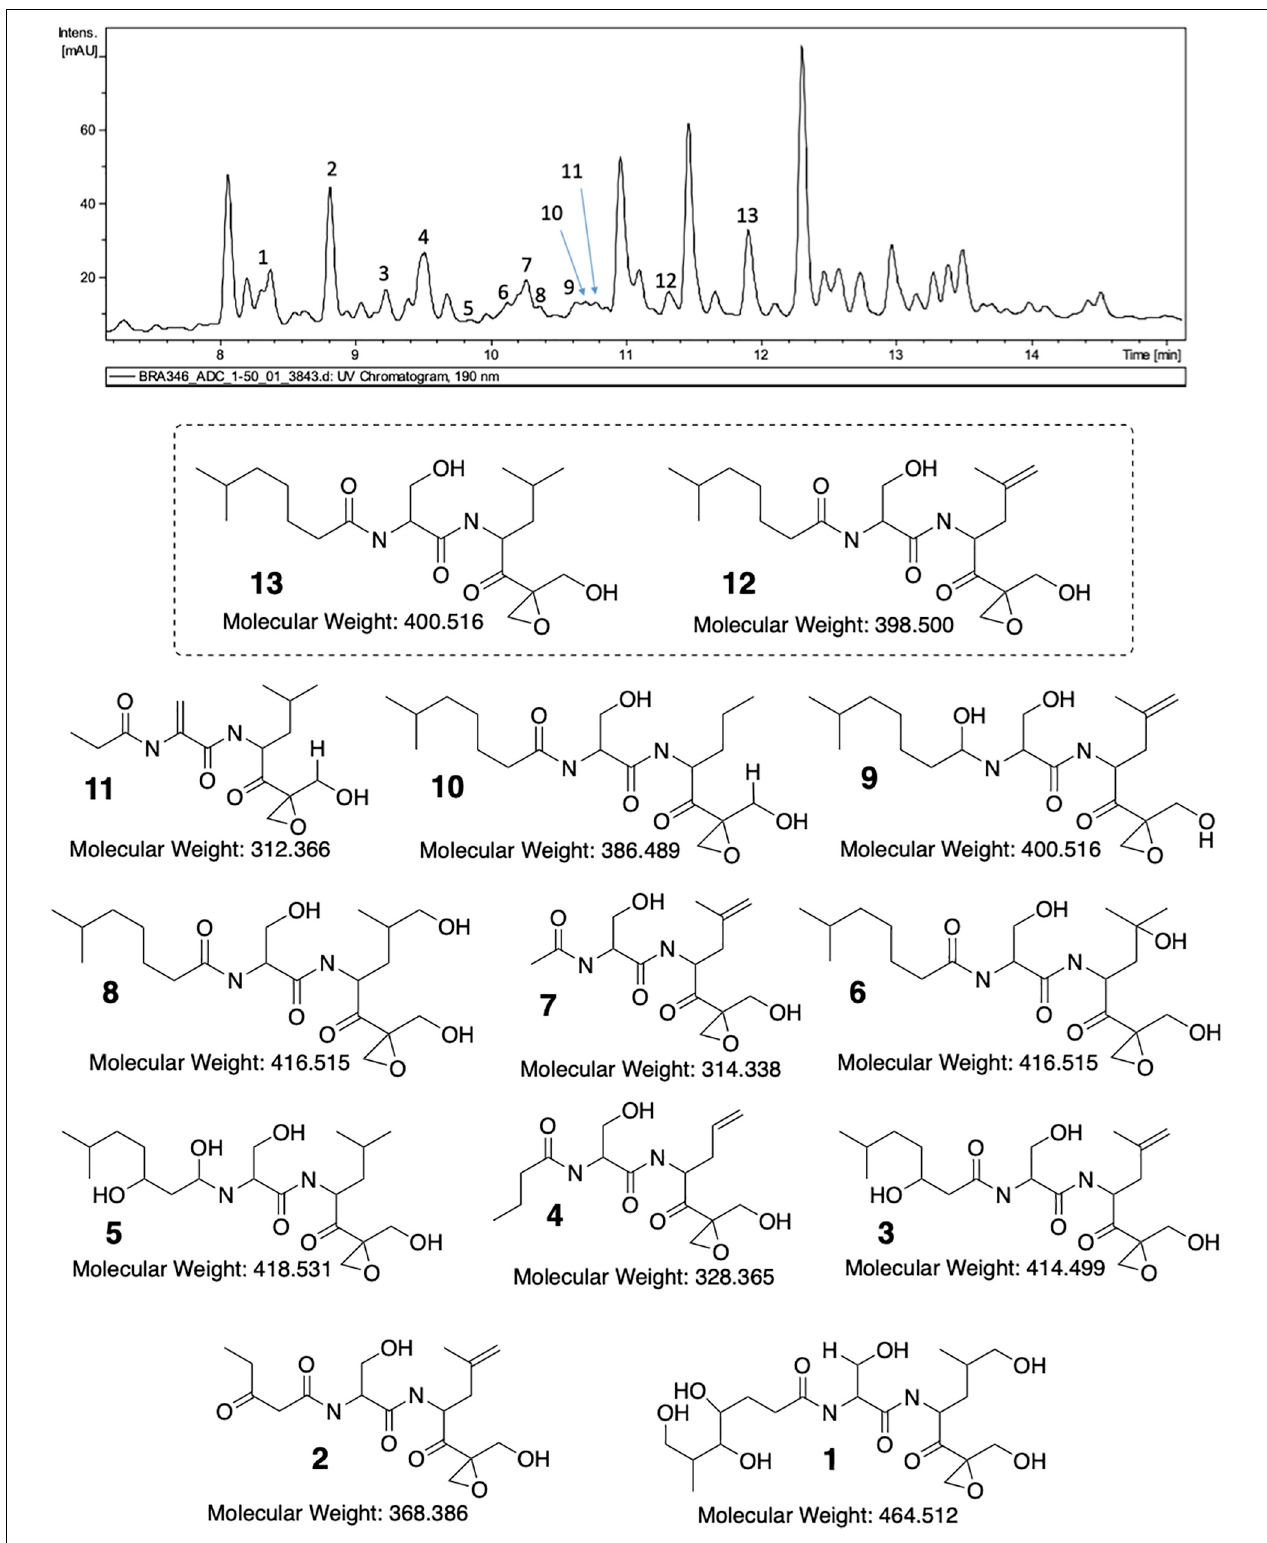
FIGURE 4 | LC-MS/MS analysis of BRA-346 fraction C (BRA-346 epoxyketone-containing fraction) and proposed structures for eponemycin derivatives.